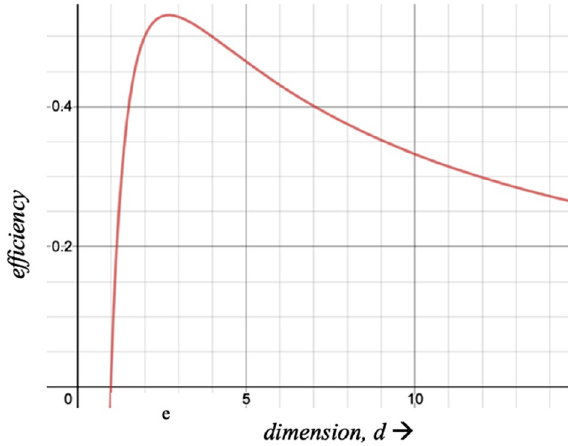
Figure 1. Dimensional efficiency is maximum at d =